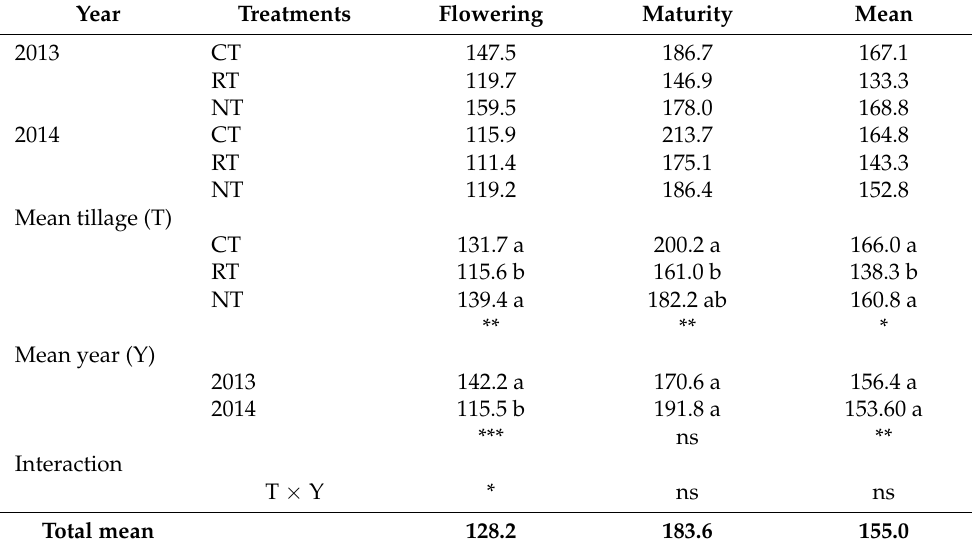
Table 6. Variation in the amount of N 2 fixed (kg N ha − 1 ) at both faba bean growth stages with respect to tillage system and study year at the Pantanelli farm (southern